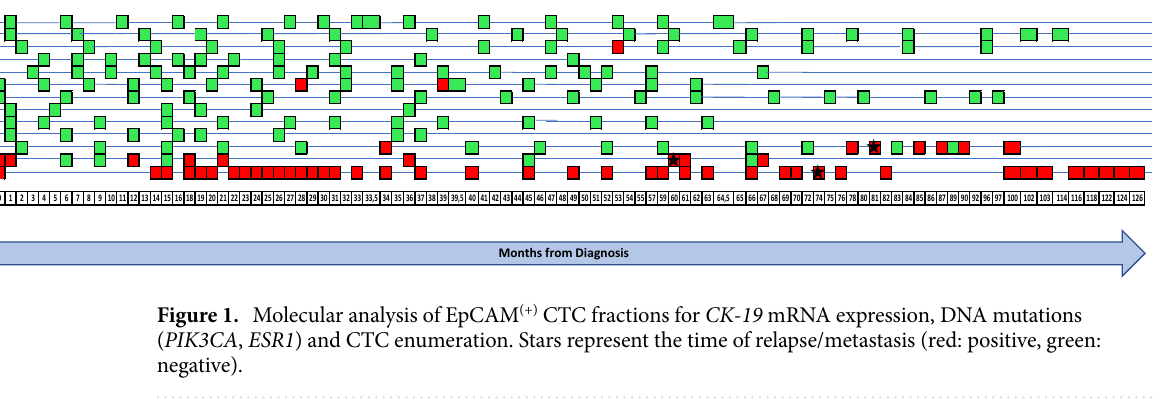
Figure 1. Molecular analysis of EpCAM (+) CTC fractions for CK-19 mRNA expression, DNA mutations ( PIK3CA , ESR1 ) and CTC enumeration. Stars represent the time of relapse/metastasis (red: positive, green: